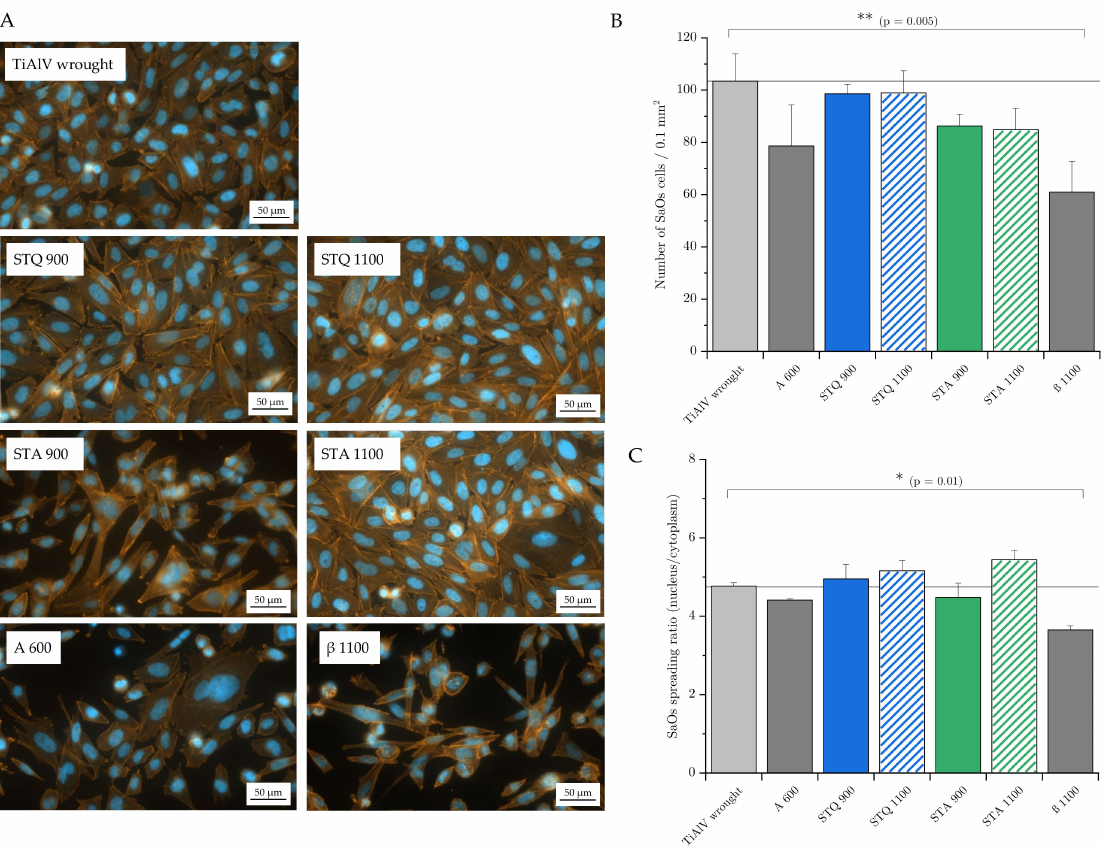
Figure 8. Osteoblast adhesion and spreading to heat-treated TiAl6V4 alloys. SaOs-2 cells were incubated on samples’ surfaces for 24 h at 37 ◦ C. ( A ) Exemplary photographs of SaOs-2 cells adhering to the sample surfaces after incubation (cytoskeleton: orange, nucleus: blue). ( B ) Number of adhering SaOs-2 cells per sample surface of 0.1 mm 2 . ( C ) Size ratio of nucleus to cytoplasm indicating cell spreading for the tested samples (data as mean ± SD, n = 3, N = 5, analyzed for statistical significance with one-way ANOVA with Bonferroni post-hoc test, * p < 0.05; ** p <